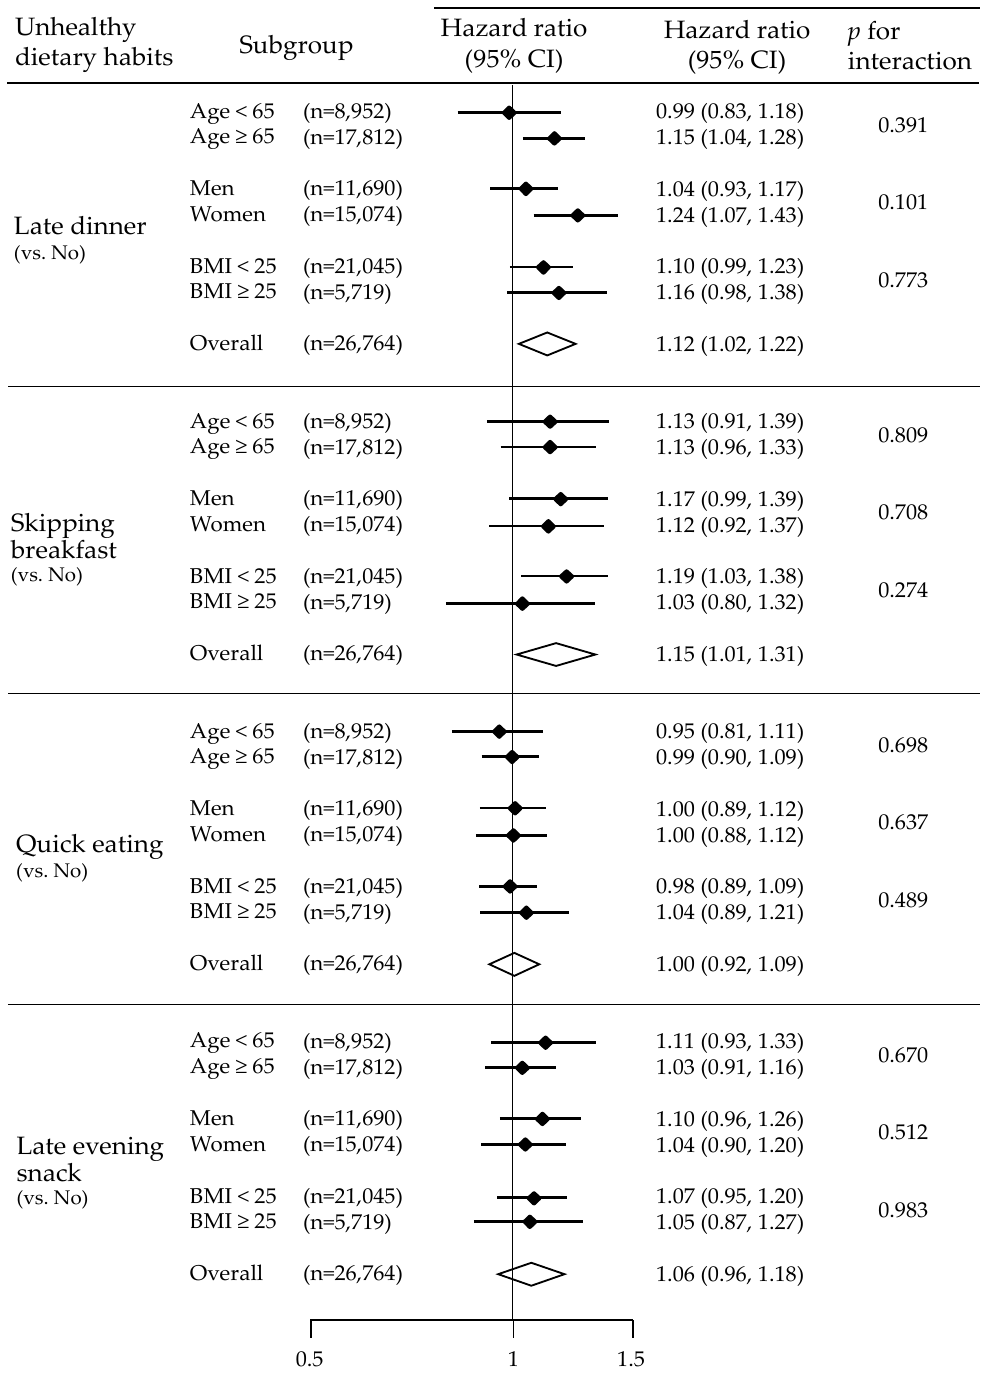
Figure 4. Association between unhealthy dietary habits and proteinuria onset according to the baseline categories of age, sex, and body mass index. Adjusted for age, sex, body mass index, systolic blood pressure, estimated glomerular filtration rate, hemoglobin, triglyceride, total cholesterol, HbA1c, serum uric acid, daily drinking, and current smoking. (When the variable of subgroup was included in the explanatory variable, it was excluded from adjustment.).